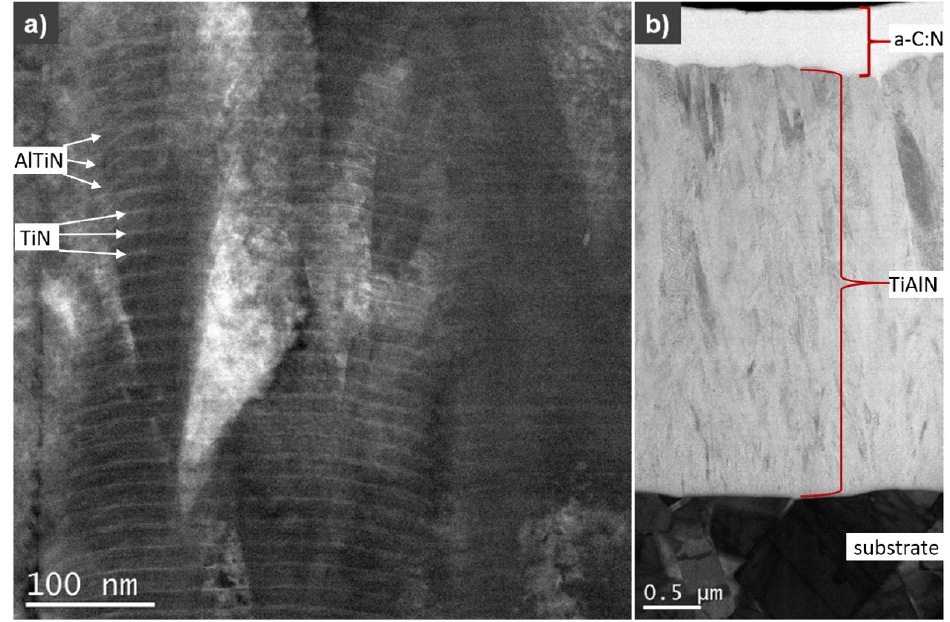
Figure 4. A TEM image of cross-section of a TiN/AlTiN 5 µm thick coating ( a ) and TiAlN/a-C:N 5 µm thick coating ( b ) obtained on the Co-M substrate.